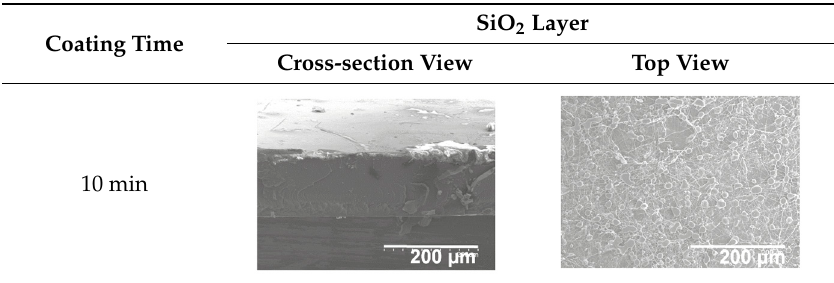
Table 2. Field emission scanning electron microscope (FESEM) micrographs of the cryofractured cross-sections and top views of the nanostructured multilayer films of low-density polyethylene (LDPE) coated with electrospun ultrathin poly( ε -caprolactone) (PCL) fibers and electrosprayed silica (SiO 2 ) microparticles. The PCL deposition time was kept constant at 2 h. The SiO 2 nanostructured microparticles were deposited at different time intervals, namely 10, 20, 30, 40, 50, and 60 min, and later, subjected to annealing.